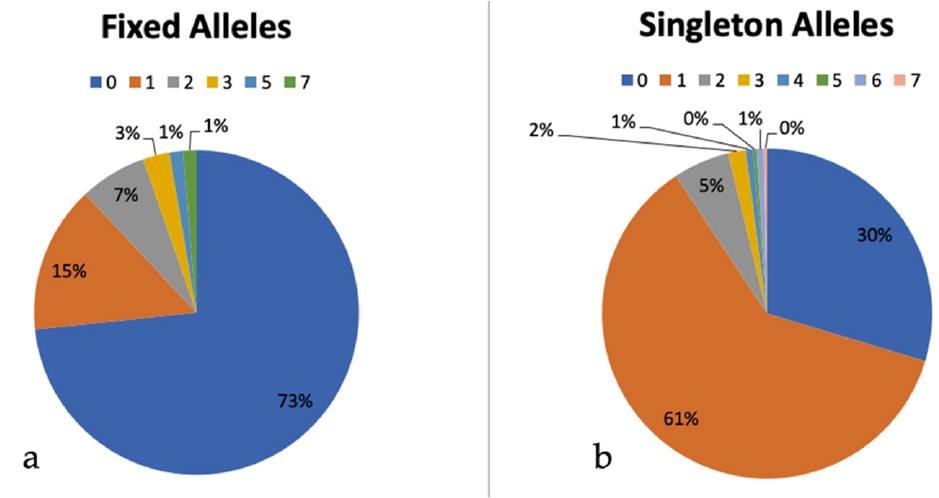
Figure 12. ITS1 variation observed within specimens. The fixed alleles graph ( a ) shows the percentages in which Sanger sequences presented ambiguities (0–7) in the ITS1 (e.g., an “R” whereas the Illumina reads showed either an “A” or “G”, the majority showing none). The singleton alleles graph ( b ) shows the percentage of ASVs in which Illumina reads differed from the Sanger sequences by 0–7 base pairs aside from the fixed alleles (e.g., 61% of all ASVs showed 1 bp different then the corresponding Sanger sequence they were being compared to).